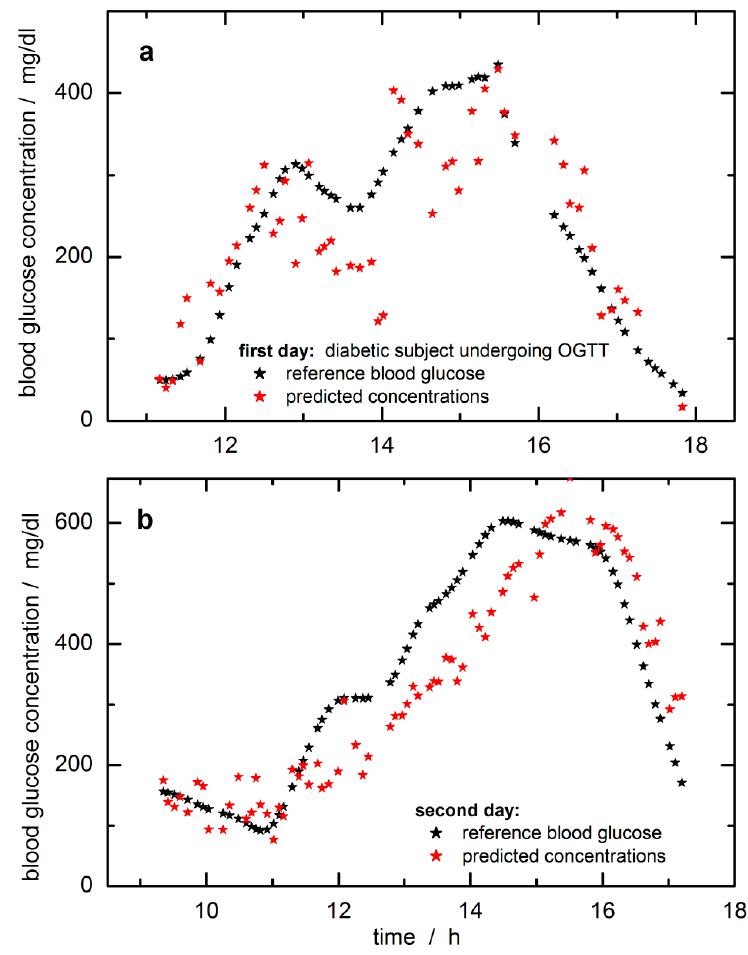
Figure 6. Predictions of tissue glucose concentrations versus blood glucose values for the first day ( a ) and the second day of the modified oral glucose tolerance test (OGTT) ( b ); tissue concentrations were calculated with the SBC-calibration model using reflection lip spectra and glucose absorptivities scaled with photon penetration depth (results were offset corrected, see also text). Spectra and reference blood glucose concentration data are from previous publications [31,33]; calibration interval was from 8994–5477 cm − 1 (115 data points) with noise covariance calculated from differences of lip spectra less than 8 min apart.